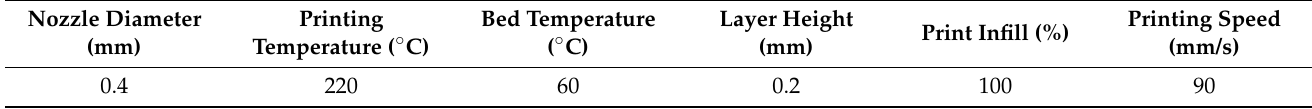
Table 2. Printing parameters for PETG